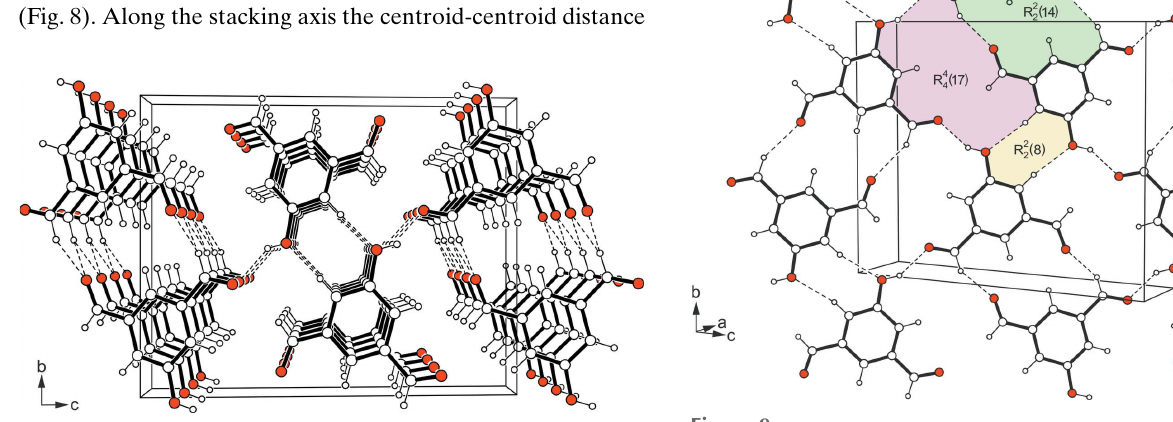
Figure 8 Packing diagram of 3 viewed down the a -axis. Dashed lines represent hydrogen bonds.